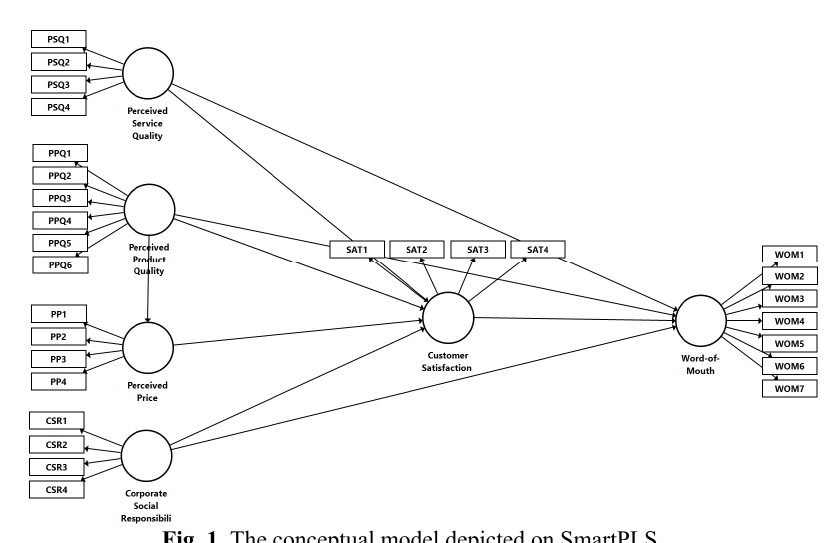
Fig. 1. The conceptual model depicted on